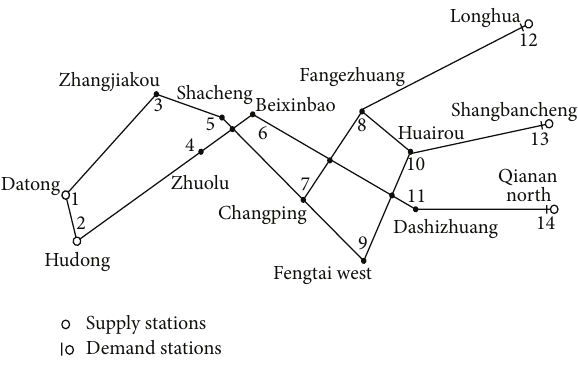
Figure 8: The network of the real-life railway network.